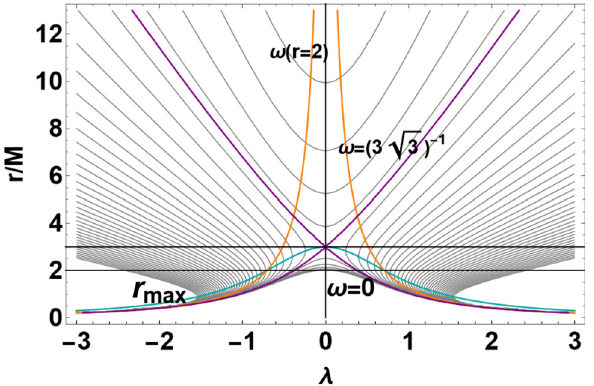
Fig. 12 Metric bundles of the static wormhole metric of Eq. (38) for θ = π/ 2 and M = 1. The plotted radii { r , r , r (cid:19) } are defined in 0 max Eqs. (41) and (40). λ is a dimensionless parameter defining the throat. ω is the bundle frequency. Purple curves are the limiting bundles with √ frequency ω = 1 / 3